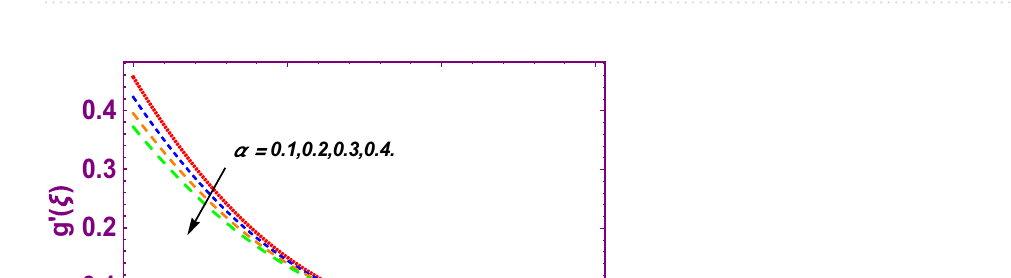
Figure 8. Effect of slip parameter on f ′ (ξ) .